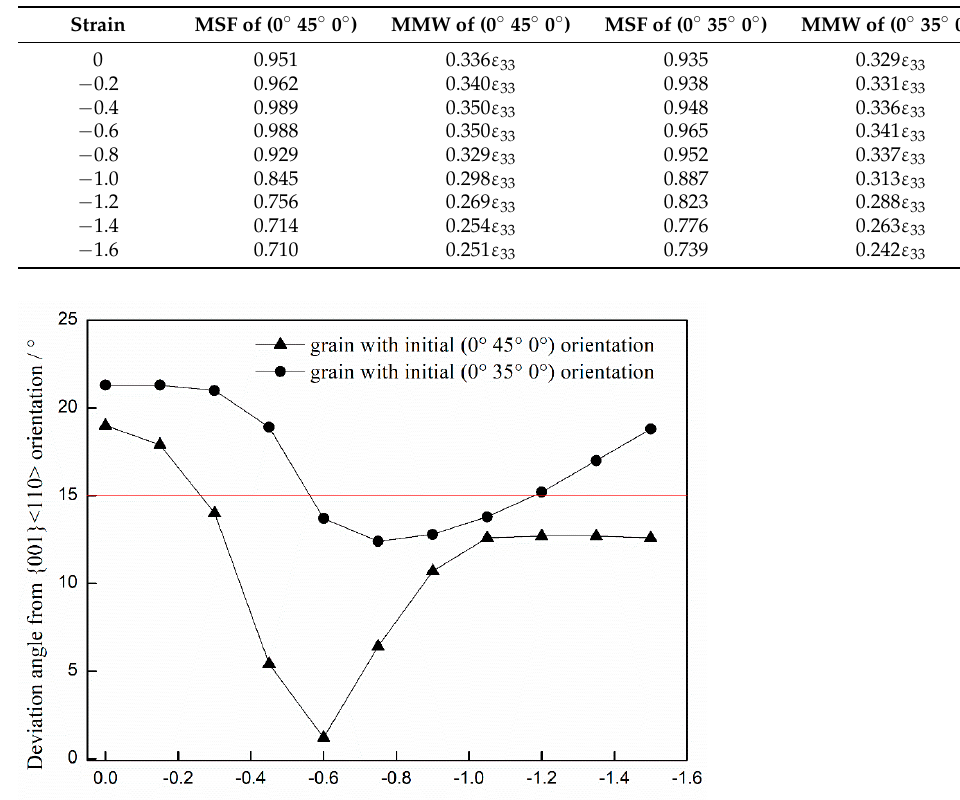
Figure 9. The orientation rotation path of (0 ◦ 35 ◦ 0 ◦ ) orientation; ( a ) and corresponding twinning orientation ( b ) during cold rolling, strain = − 0.6. Table 2. Schmid factor and shear mechanical work of (0 ◦ 45 ◦ 0 ◦ ) orientation and (0 ◦ 35 ◦ 0 ◦ ) orientation at different strain in cold rolling (MSF and MMW represent maximum Schmid factor and shear mechanical work, respectively).